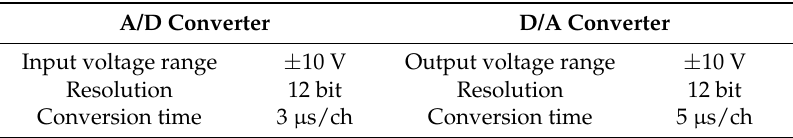
Table 3. The specification of an amplifier.